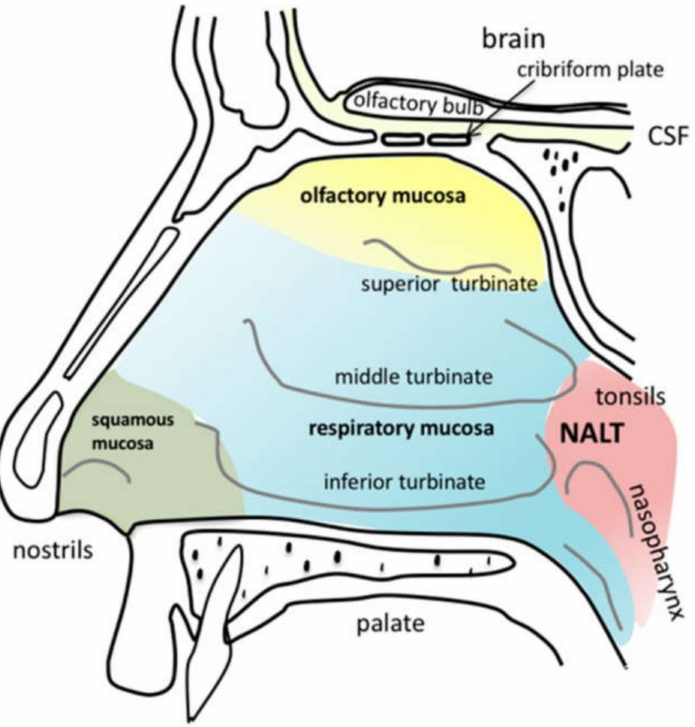
Figure 1. Anatomy of the human nasal cavity. Squamous mucosa ( green ) is located at the frontal parts of the nasal vestibules. The three turbinates (inferior, middle, and superior) humidify and warm the inhaled air. The area covered predominantly with respiratory mucosa is labeled in blue. The olfactory mucosa ( yellow ) is located next to the cribriform plate at the skull base down to the superior turbinate. Nasally transmitted substances can cross the cribriform plate via different pathways to enter the brain. Nasopharynx-associated lymphatic tissue (NALT) is located in close proximity to the tonsils at the nasopharynx. Reproduced from [13], MDPI,